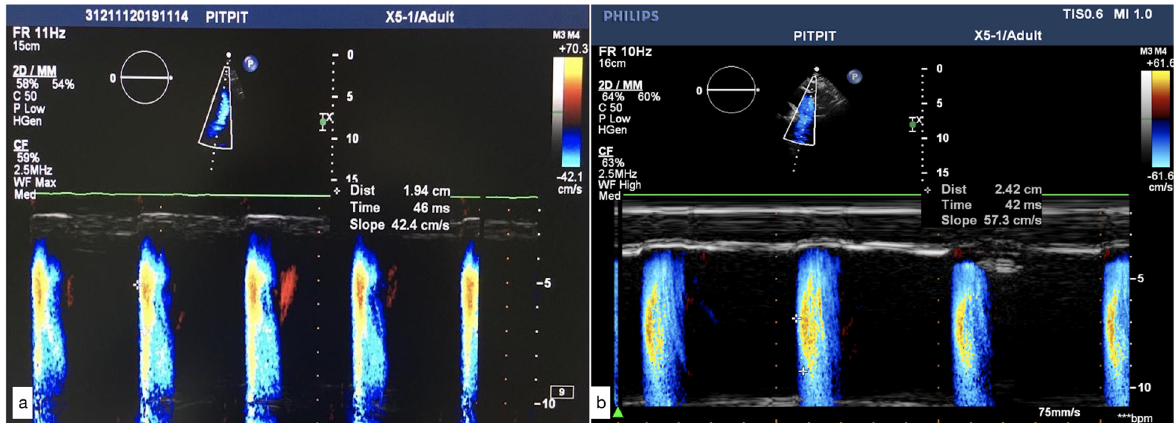
Figure 1. Aortic velocity propagation (AVP) in a patient with diabetes mellitus disease (AVP=42.4 cm/s) (Figure 1a), and in a control subject (AVP=57.3 cm/s) (Figure 1b). The AVP was calculated by dividing the distance between points corresponding to the beginning and end of the propagation slope by the duration between corresponding time